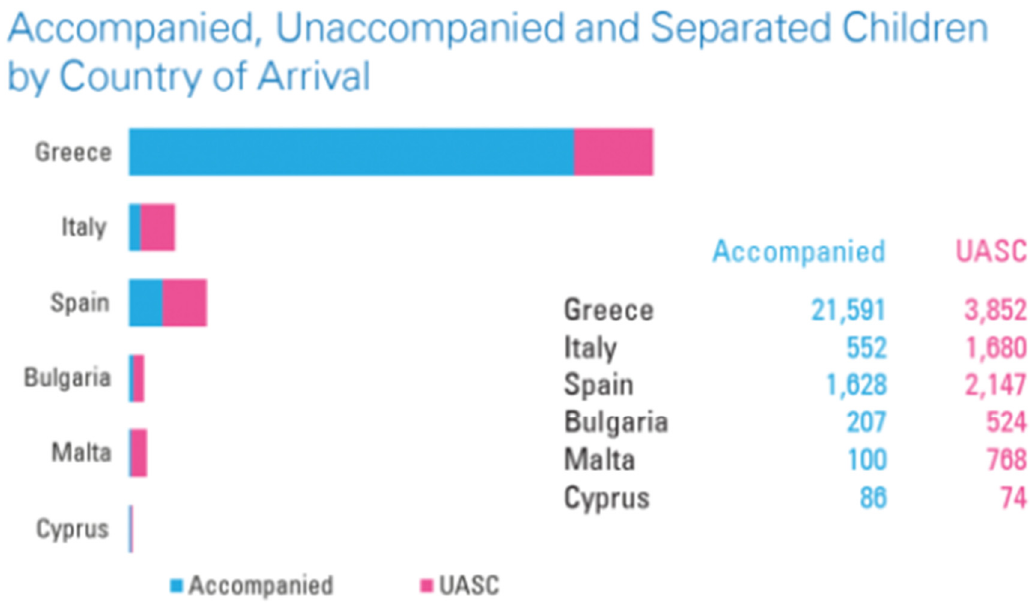
Figure 1. Accompanied, and unaccompanied and separated children (UASC) by country of arrival between January and December 2019 (UNHCR 2019) .